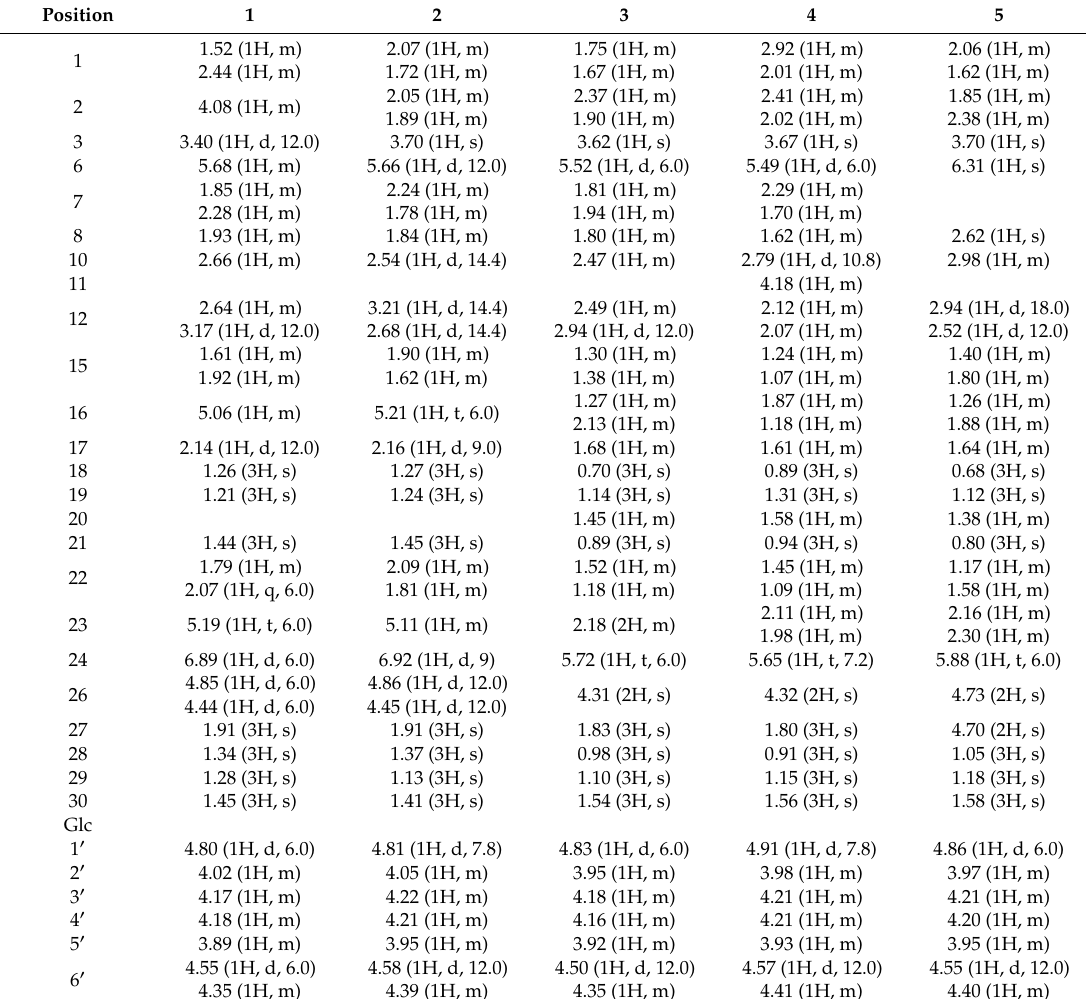
Table 1. 1 H-NMR Spectra Data (600 MHz, pyridine- d 5 ) for Compounds 1 – 5 ( δ H in ppm, J in Hz).